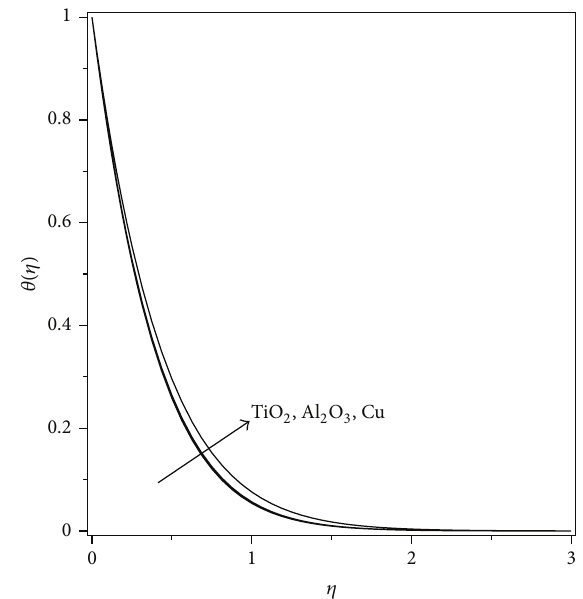
Figure 2: Dimensionless temperature profiles 𝜃(𝜂) for different types of nanoparticles when 𝜙 = 0.1 and 𝑚 = 0 .